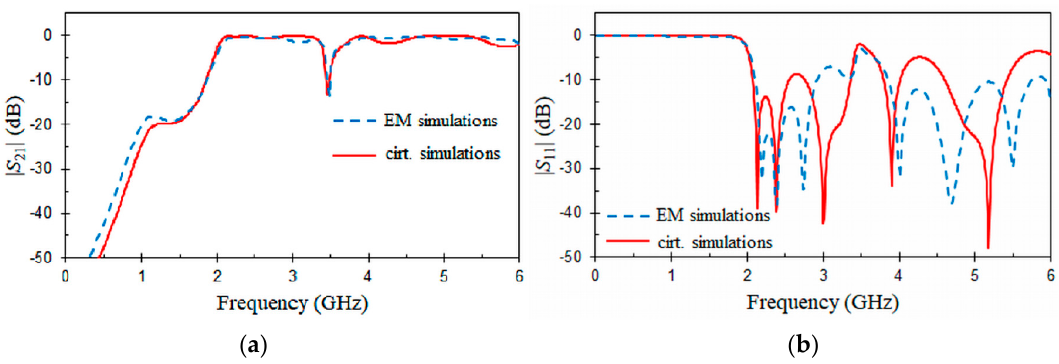
Figure 8. EM and circuit frequency responses for the HMSIW structure loaded with an ORR cell ( a ) | S 21 | (dB) and ( b ) | S 11 | (dB). Dimensions (mm) and permittivity: r = 1.9, c = 0.3, g = 0.2, D 1 × D 2 = 8 × 8, W HMSIW = 11.65, s = 1.2, d = 0.6, W m = 0.594, W t = 4.66, L 1 = 5, L 2 = 11, L t = 28.95, t = 0.017, h = 0.635, and ε r = 10.2 (tg δ = 0).